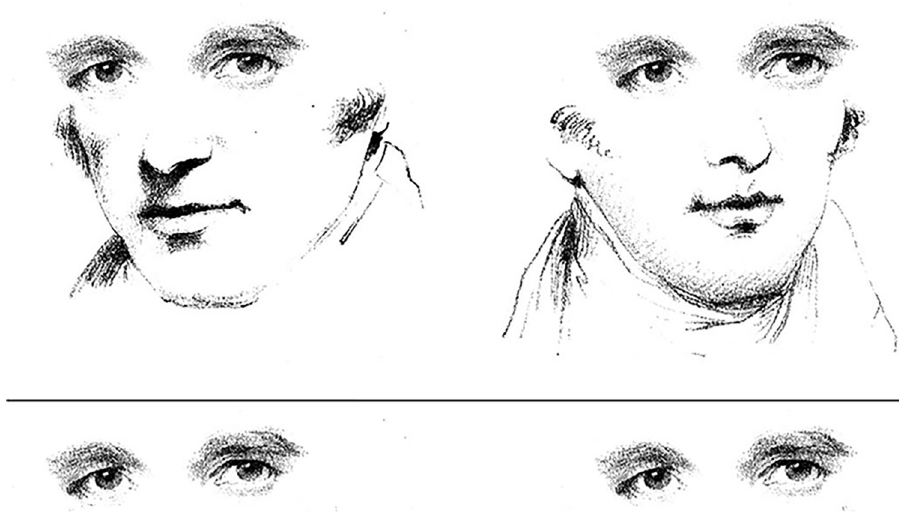
Fig 1. Eyes with identical pupil rotations appear to have unique gaze directions when coupled with leftward or rightward head rotations [8].